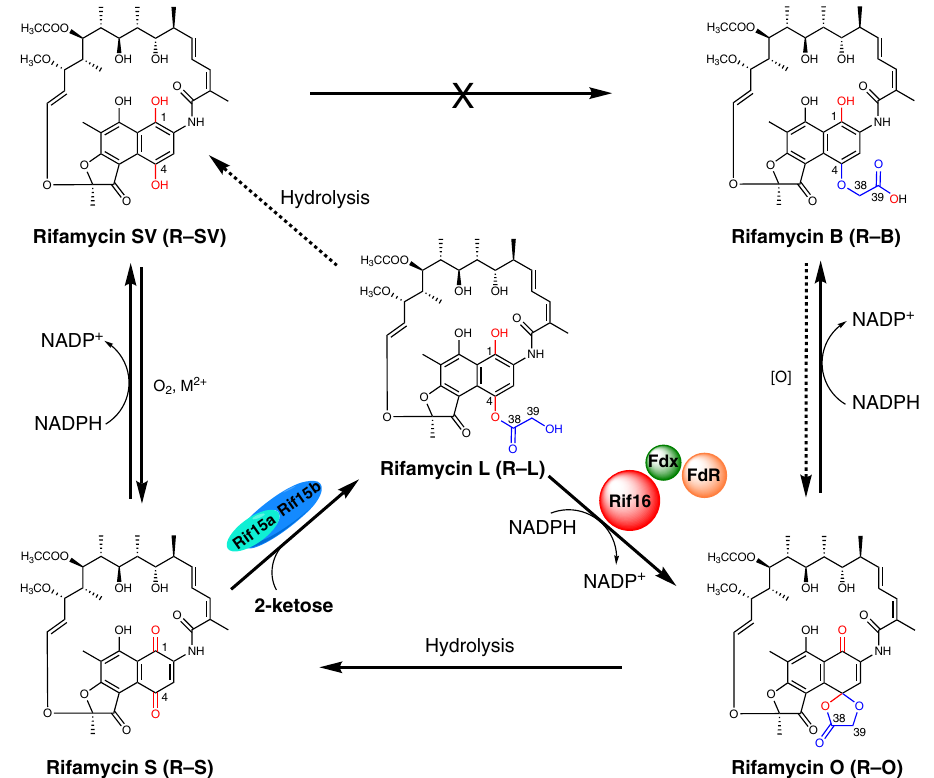
Fig. 1 The biosynthetic network of late rifamycin derivatives. R-SV can be oxidized to R-S spontaneously in the presence of dioxygen and divalent metal ions. The transketolase Rif15 is responsible for transferring a C 2 keto-containing fragment from a 2-ketose to R-S, giving rise to R-L. The P450 enzyme Rif16 catalyzes the transformation from R-L to R-O in the presence of NADPH, ferredoxin (Fdx), and ferredoxin reductase (FdR). Finally, R-O is non- enzymatically reduced to R-B by